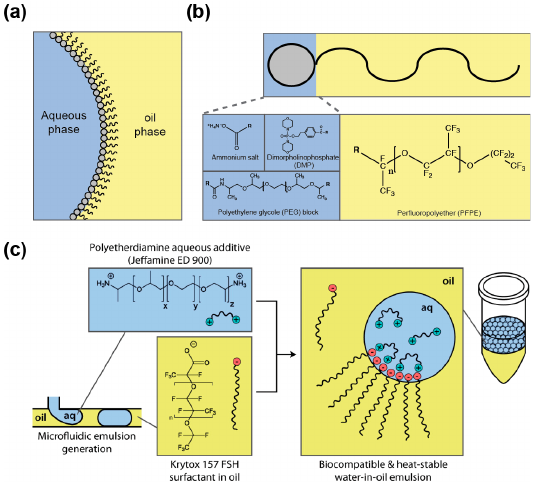
Figure 5. Chemical structure of fluorinated surfactants. ( a ) Surfactants are amphiphilic molecules that stabilize droplets by partitioning at water/oil interface. ( b ) Structure of the fluorinated surfactants. Perfluoropolyether (PFPE) fluorinated tail (shaded in yellow) is covalently attached to different polar head groups (shaded in blue). ( c ) Droplet stabilization by bipartite surfactant. Krytox™ 157 FSH fluorinated tail (shaded in yellow) stabilizes the droplet by partitioning at the interface and interacts with Jeffamine ED 900 polar head group (shaded in blue) by ionic interactions. Reprinted with permission [117]. Copyright 2013 American Chemical Society.